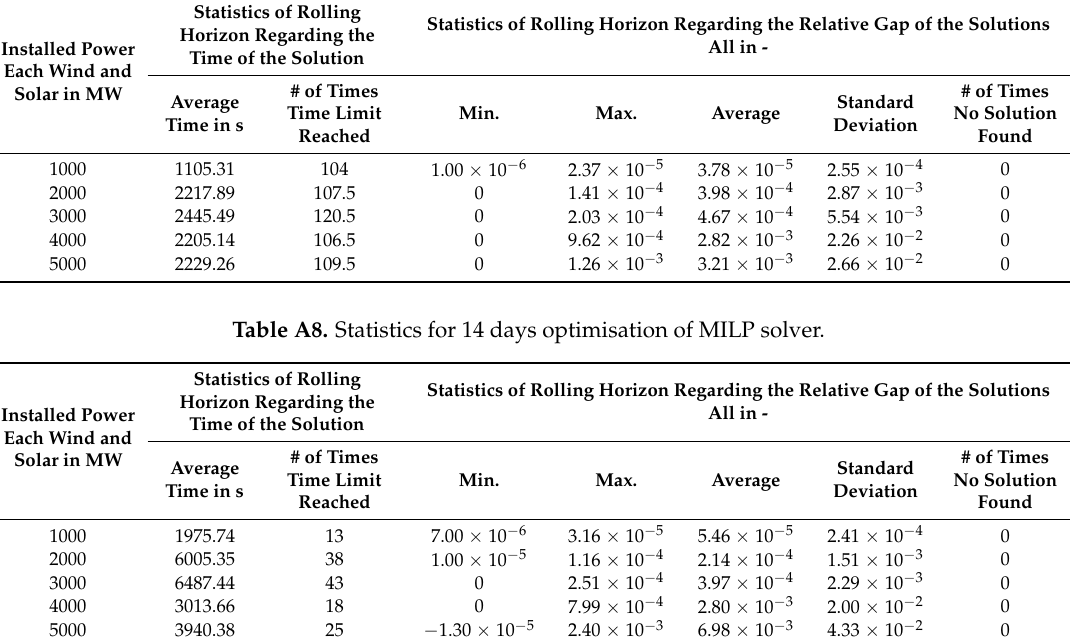
Table A7. Statistics for 5 days optimisation of MILP solver.